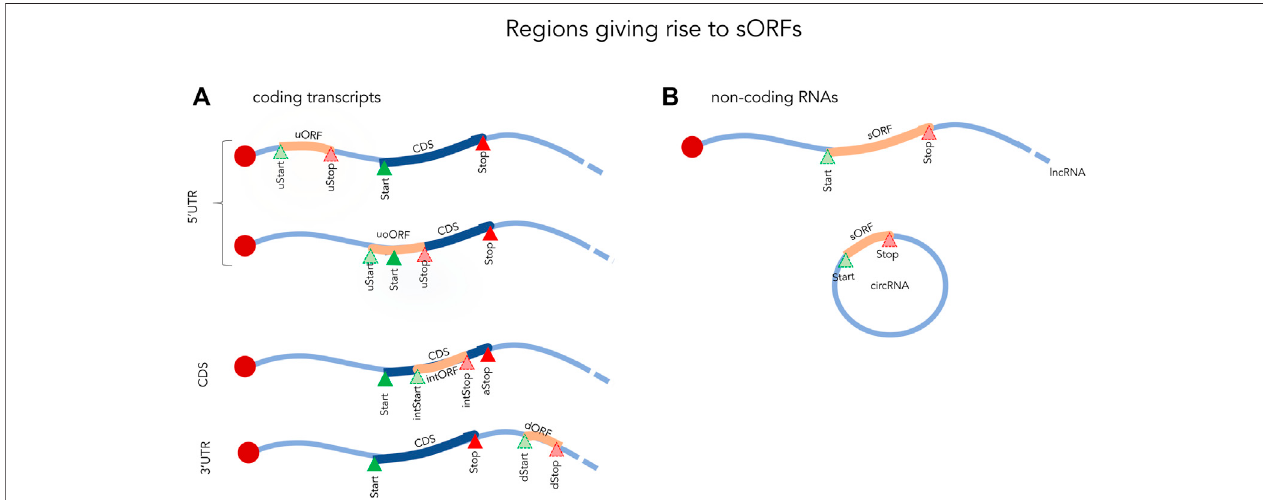
FIGURE1| ExamplesofsmallORFsincoding (A) andnon-coding (B) transcripts.StartandStopindicatetheinitiationandterminationsitesofthecodingsequence (CDS). uORF, upstream open reading frame fully located in the 5 ′ UTR; uStart, upstream start site; uStop, upstream stop site; uoORF, upstream overlapping open reading frame; intStart, internal start site; intORF, internal open reading frame; intStop, internal stop site; dStart, downstream Start site; dStop, downstream stop site; sORF, small open reading frame; lncRNA, long non-coding RNA; circRNA, circular RNA.